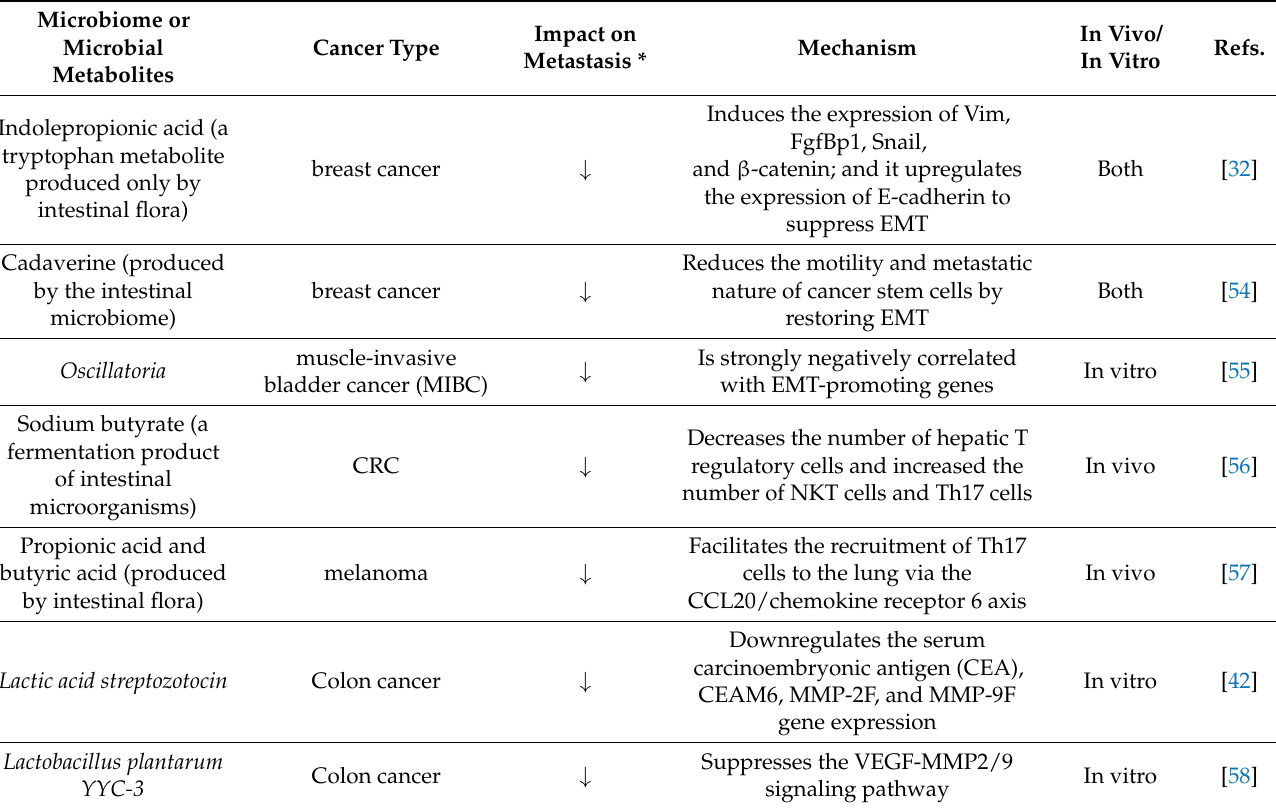
Table 2. Summary of anti-metastatic microbiome